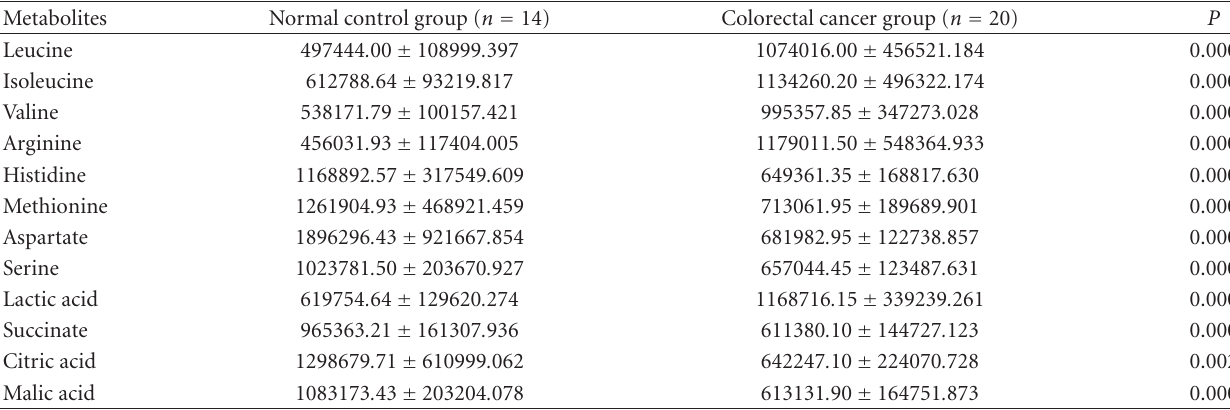
Table 2: Di ff erent metabolites identified in normal control group and colorectal cancer group (mean ± SD).